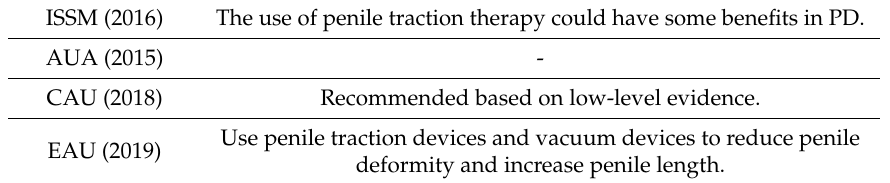
Table 3. Guidelines on Traction for Peyronie’s Disease. ISSM (2016) The use of penile traction therapy could have some benefits in